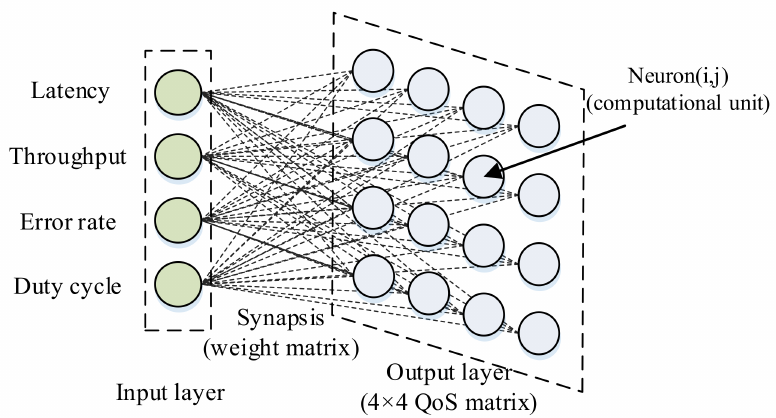
Figure 8. The ANNR model with self-organizing map architecture [66]. (Reprinted with permission from ref.